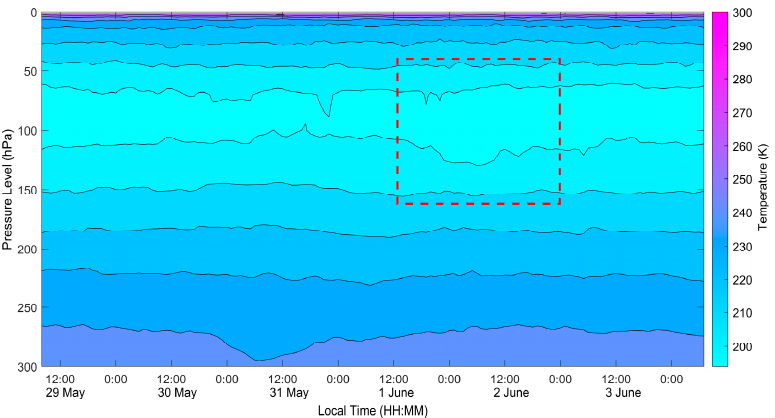
Figure 10. Temperature distribution at stratospheric heights from May 29 to June 3 (ERA 5 data). The red box highlights the temperature decreasing at heights close to the tropopause.